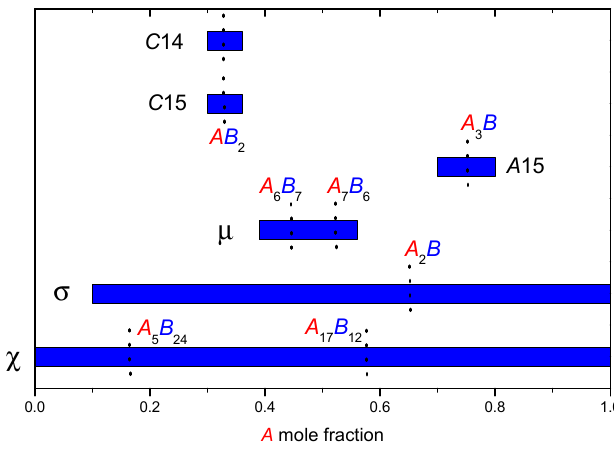
Figure 1. Homogeneity ranges of various Frank-Kasper (FK) phases in the combined systems in which they crystallize represented as a function of the composition of the larger ( A ) element. The ordered or ideal composition(s) for each phase is